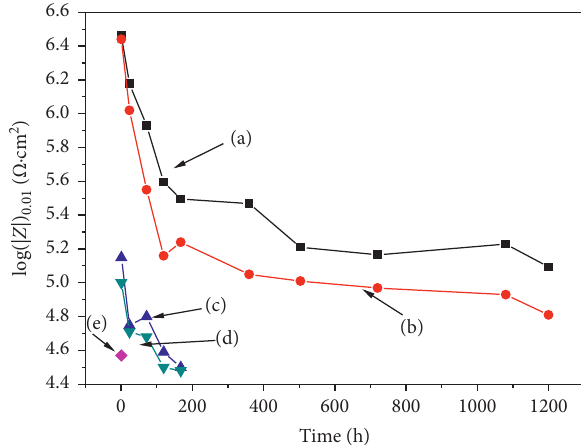
Figure 9: Impedance modulus at 0.01Hz at various immersion times: (a) CeLDH, (b) CeLDH-H, (c) LDH, (d) LDH-H,